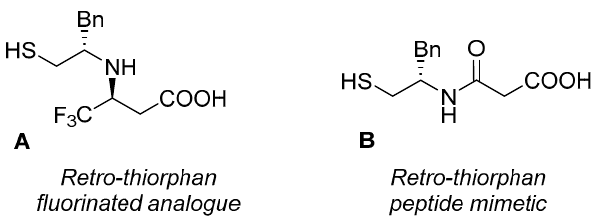
Figure 1. Retro-thiorphan peptide mimetic and its fluorinated analogue.